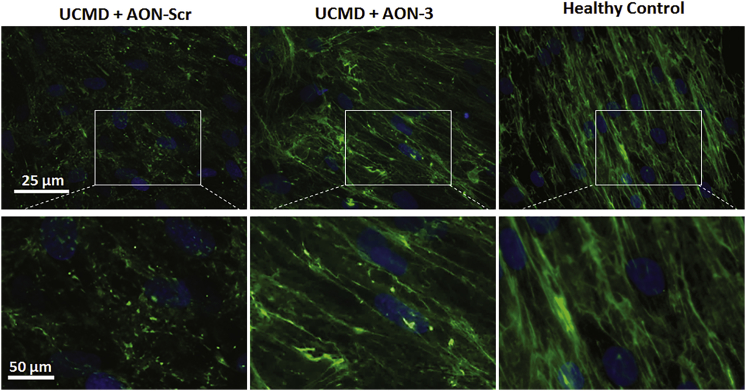
Effect of AON-3 on Collagen VI Deposition in the ECMRepresentative images of collagen VI α3 staining (in green) in unpermeabilized fibroblasts treated with scrambled AON (UCMD+AON-Scr), AON-3 (UCMD+AON-3), and healthy control fibroblasts. Higher magnification of the images is presented in the lower panel. Scale bar, 25 μm and 50 μm, respectively.